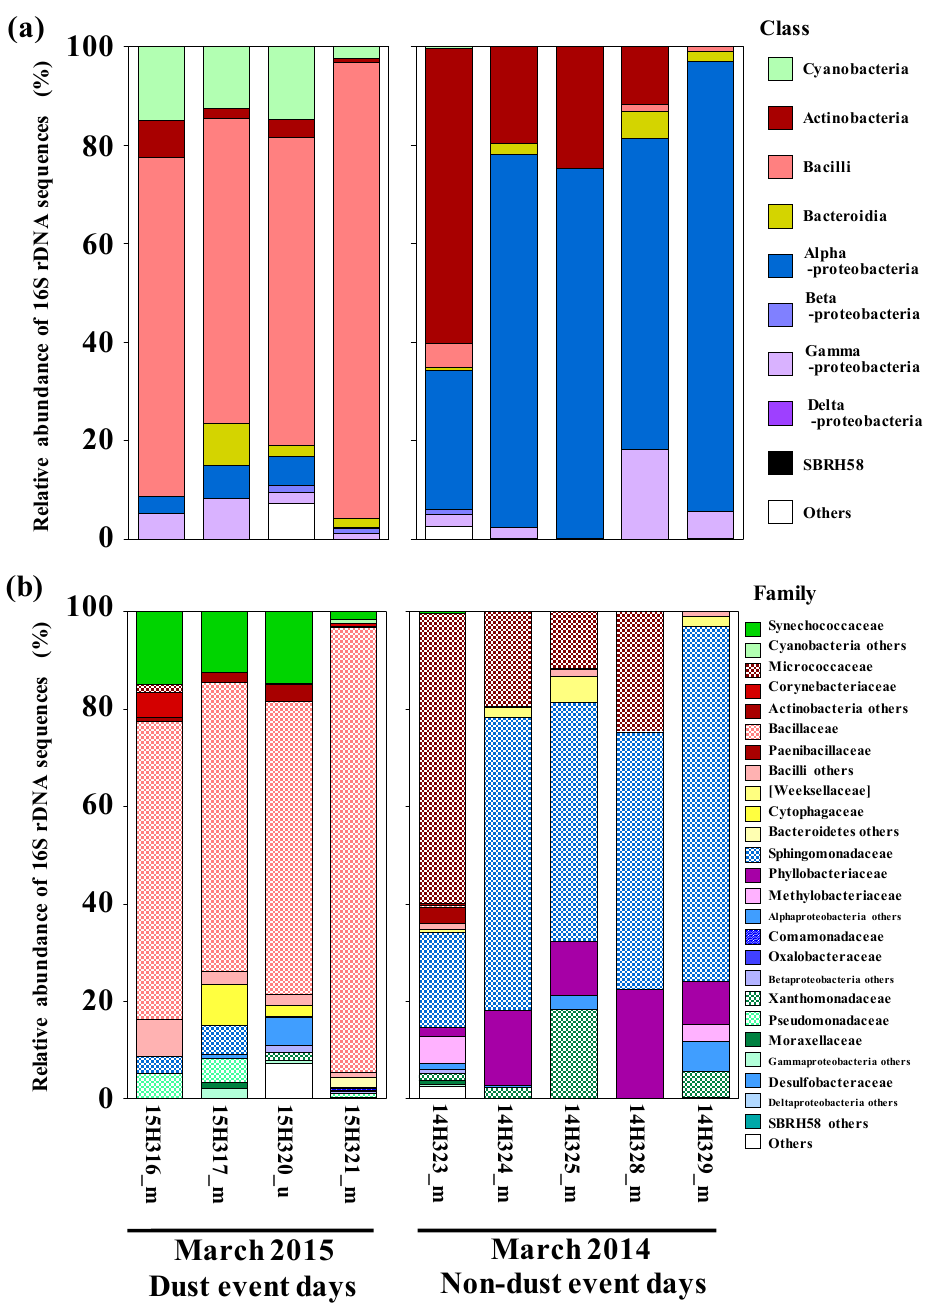
Figure 7. Changes in bacterial compositions at (a) the class level and (b) the family level of the partial sequences obtained in the MiSeq se- quencing database (ca. 400bp) from air samples collected at altitudes of 1200m (except for the sample collected at 500m on 20 March 2015) over the Noto Peninsula during dust-event days from 16 to 23 March 2015 and during non-dust-event days from 23 to 29 March 2014.